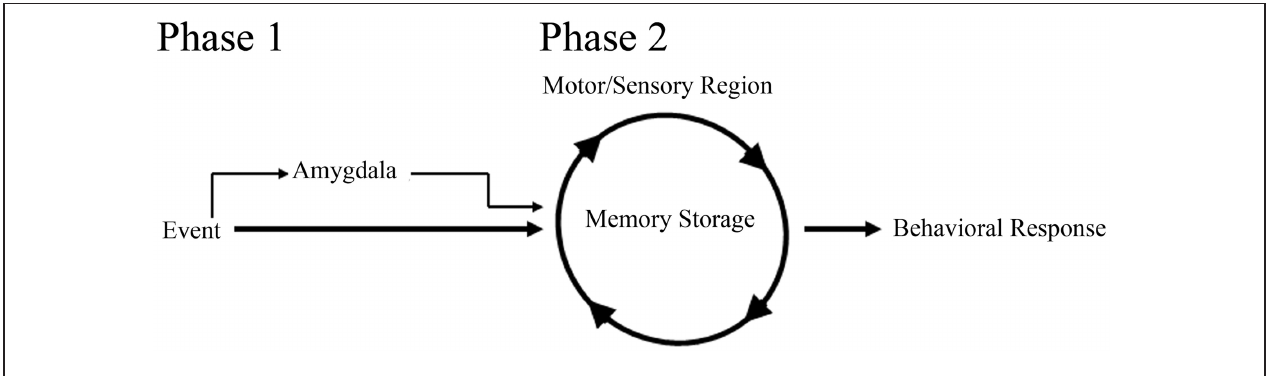
consolidation and behavioral response to the event. In phase 2 of the model, motor and sensory regions, primed with amygdala activation from phase 1, begin to solidify the memory and generate appropriate behavioral